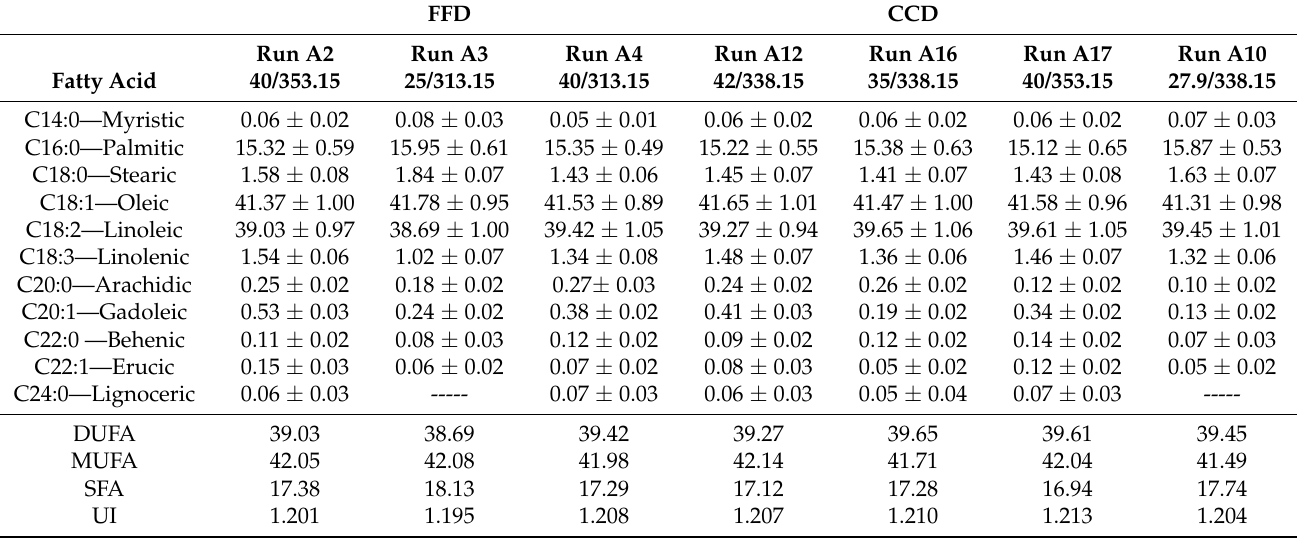
Table 5. Compositions of the esters of fatty acids obtained with scCO 2 , % mass